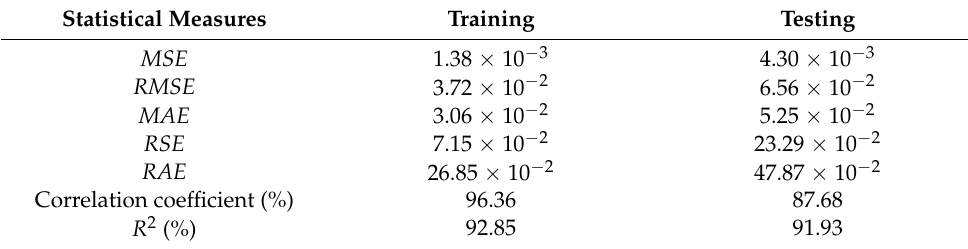
Table 6. Statistical analysis of training and testing